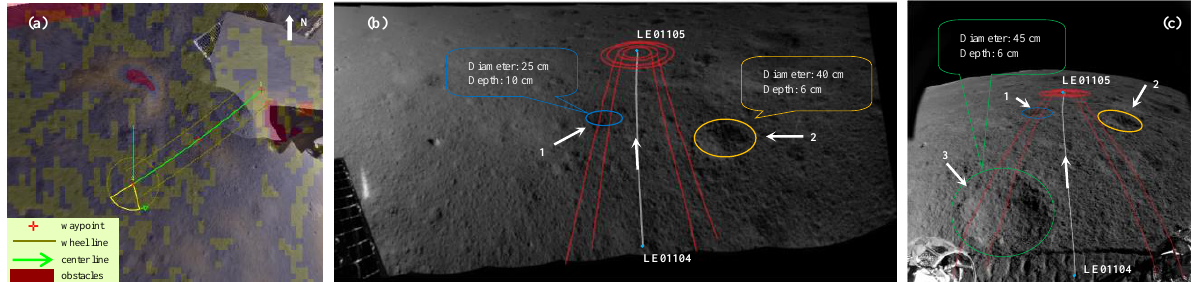
Figure 9. Path planning and projection at waypoint LE01104: (a) Planned path in overhead view; (b) Projection of the planned path on the Navcam image mosaic; (c) Projection of the planned path on the left Hazcam image. Figure 10. Comparison of planned paths (red lines) and actrual tracks at waypoint A’ and C’, respectively.